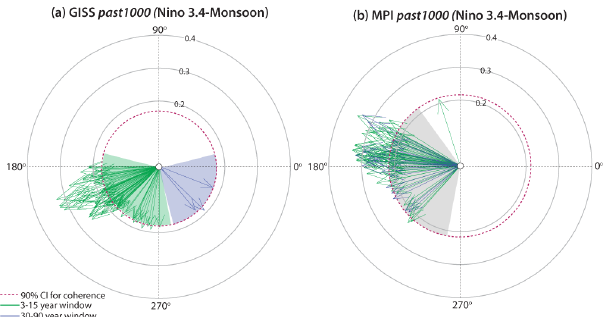
Fig. 6. Phase relationships between ENSO and the ISM for the two modeled time series in Fig. 5. Phase wheels can be interpreted iden- tically to those shown in Fig.